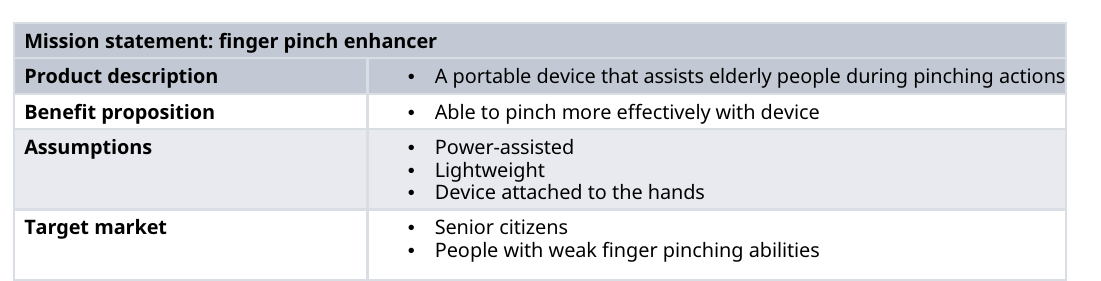
Table 4. Mission statement for finger pinch